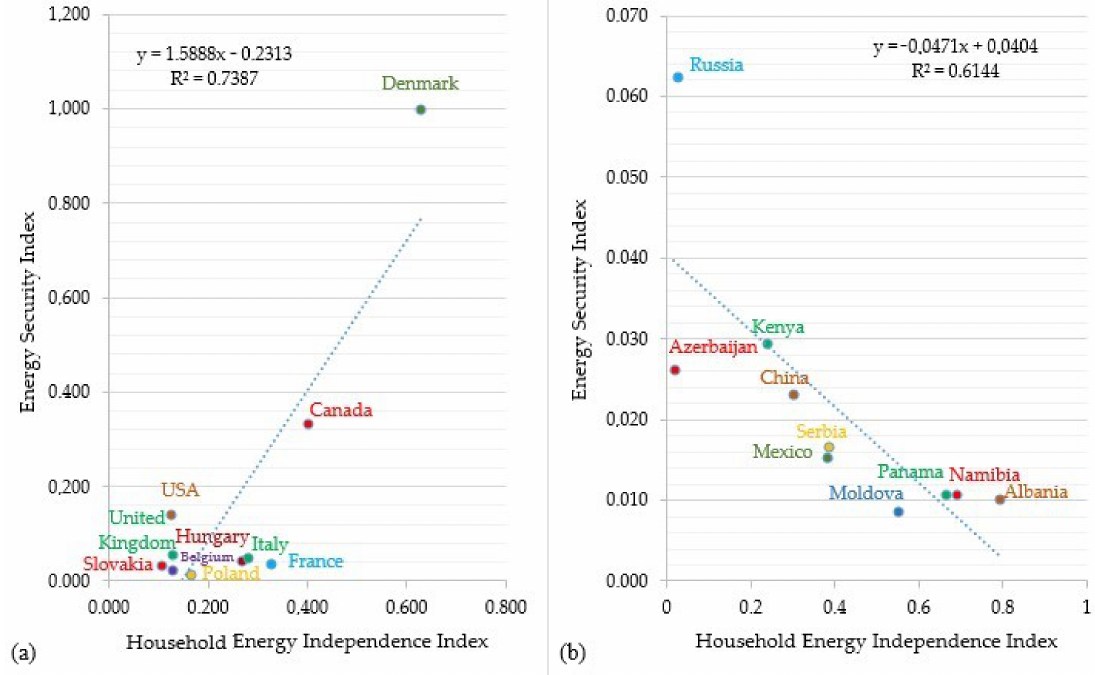
Figure 2. The relationship between a country’s energy security and a level of energy independence of households in the studied developed ( a ) and developing ( b ) countries. Source: generated by the